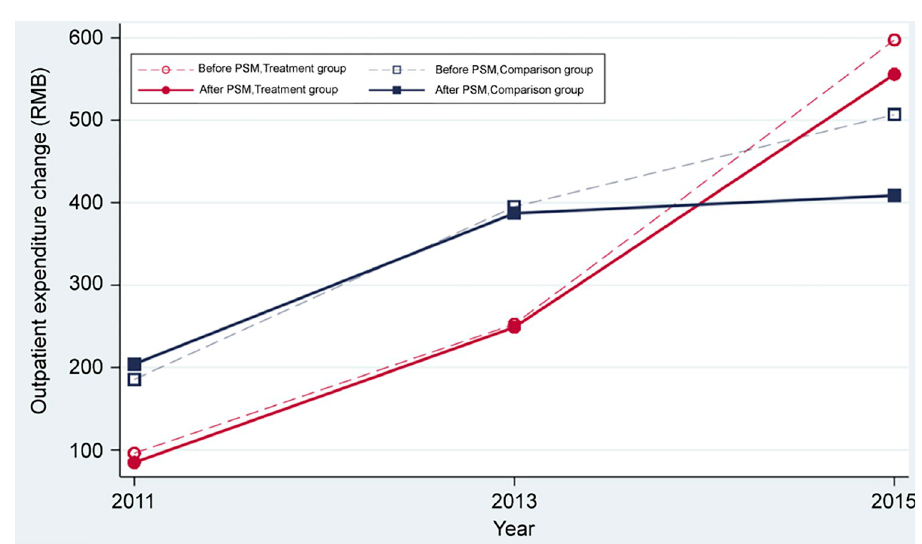
Fig 2. Comparison of outpatient expenditure of the treatment and comparison groups before and after PSM (RMB).